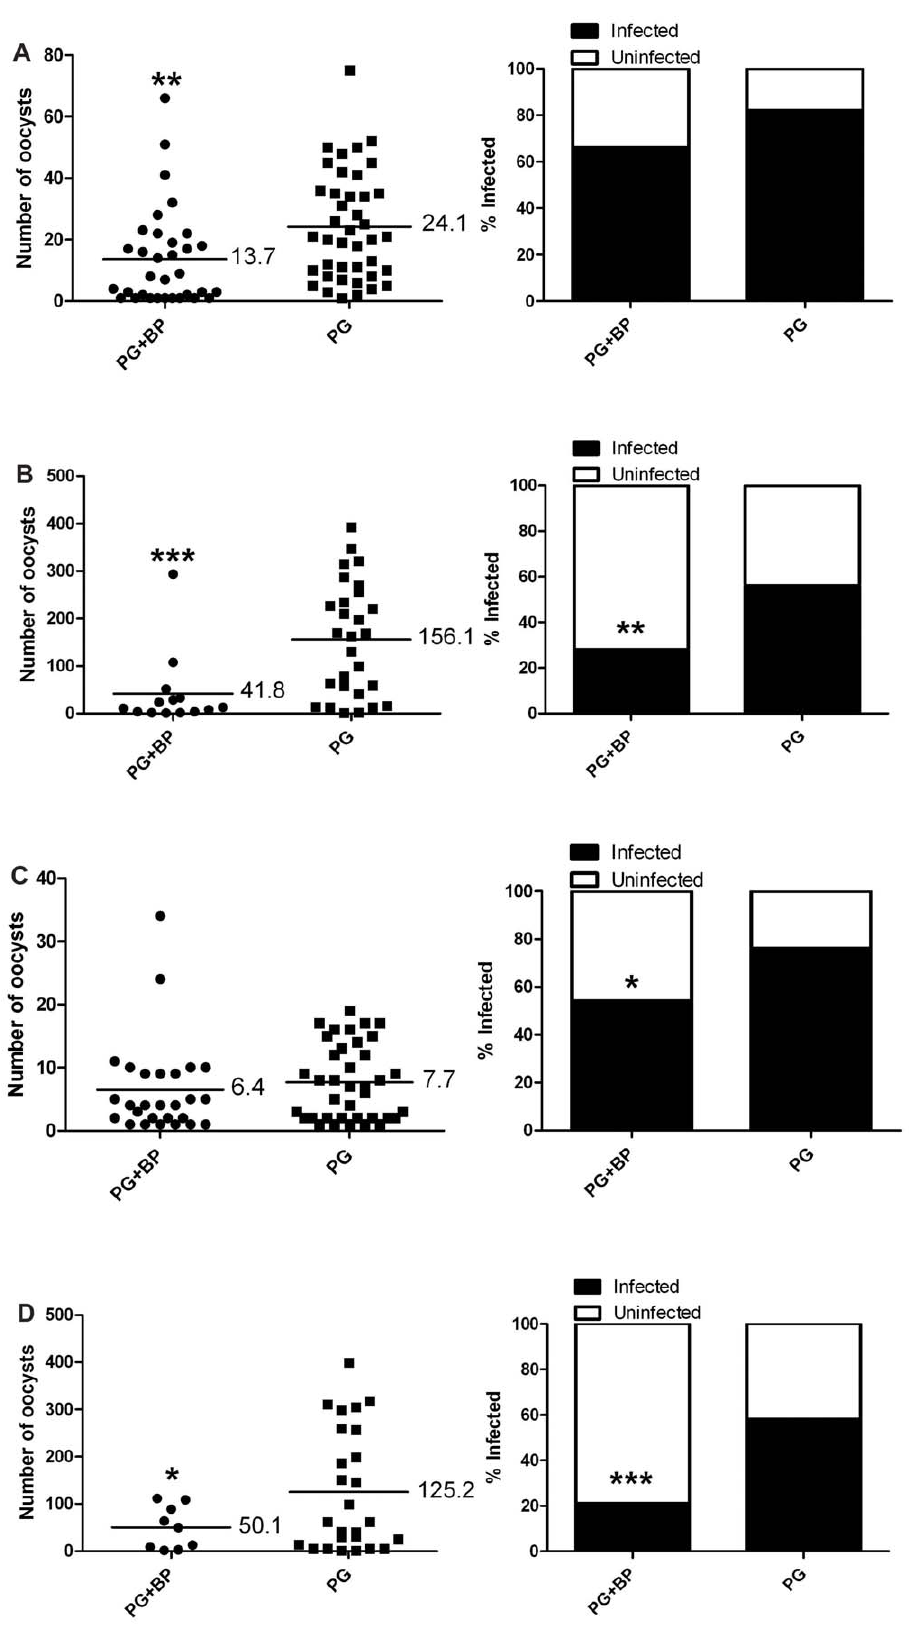
Figure 4. Plasmodium infection in Ar.subalbatus that concurrently ingested P.gallinaceum and B.pahangi. Mosquitoes that fed on blood containing P. gallinaceum alone served as controls. For all, the left panel indicates infection intensity where points indicate the absolute value of